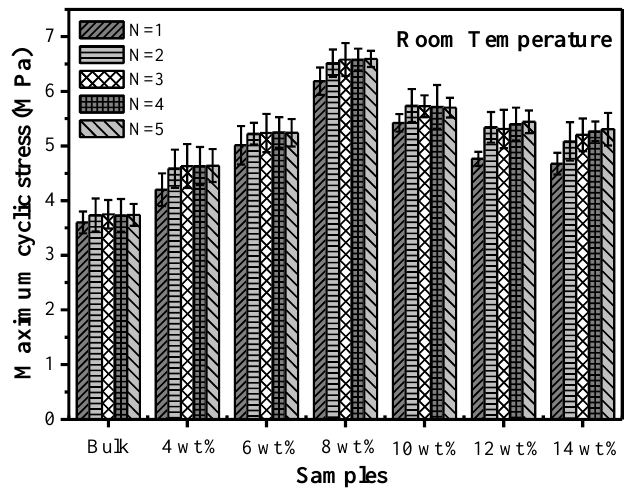
Figure 12. The effect of the number of cycles on the maximum cyclic stresses of SMP composites with different chopped carbon fiber contents.